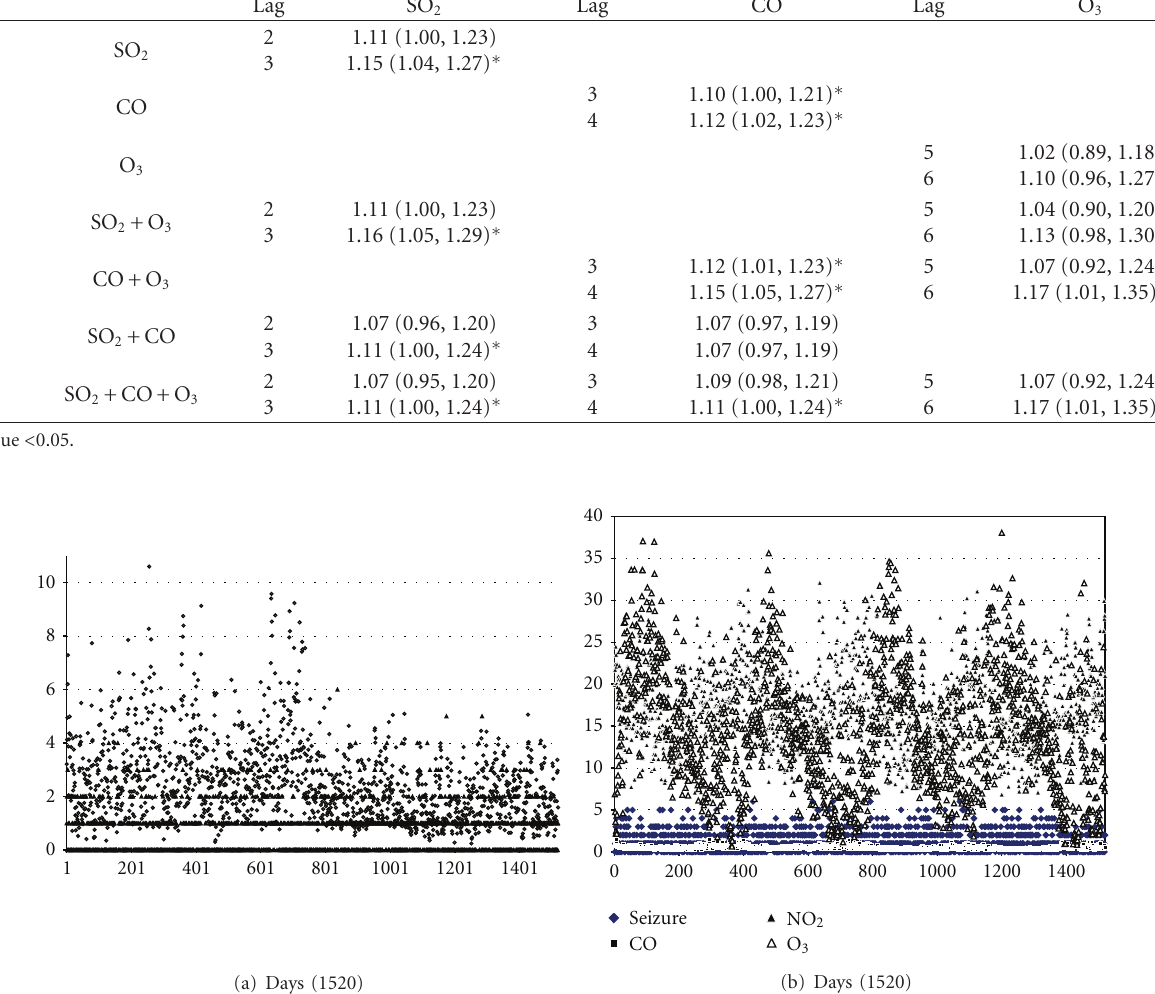
Table 3: Odds ratios and their 95% confidence intervals for ED visits for ischemic stroke. Model